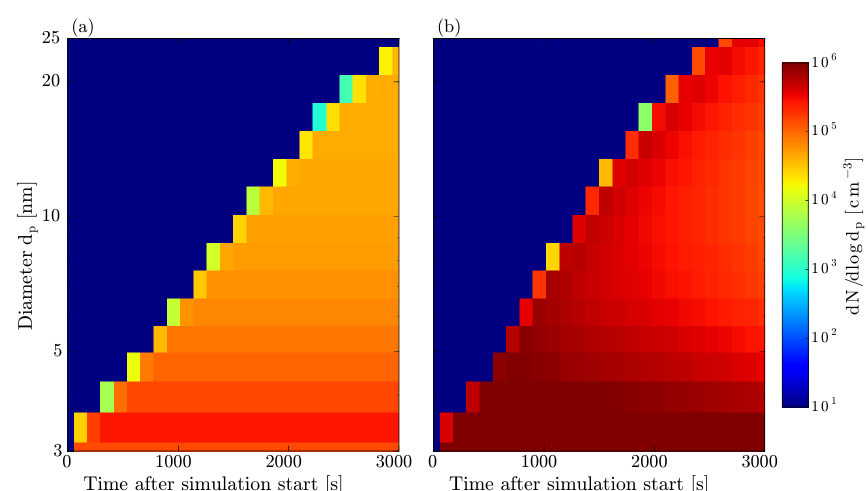
Figure D2. Size distributions generated by the SALSA module and used for the testing of the analysis methods in Sect. 3. Panel (a) shows the input used for Fig. 2, while panel (b) shows the input with a higher formation rate used for Fig.